Question: Condense the content of this figure into a single sentence.
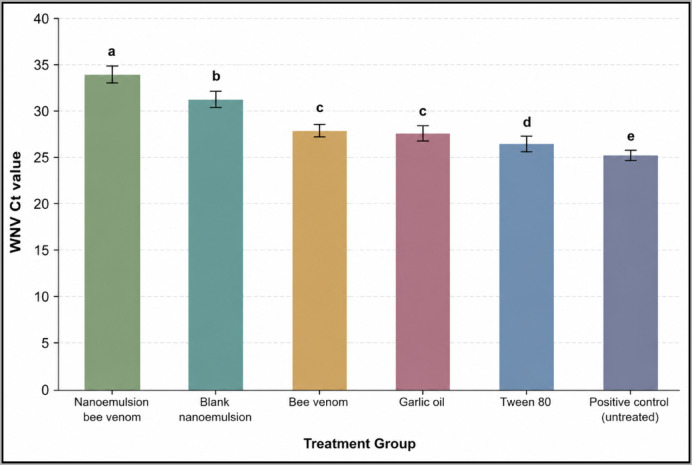
Answer: Effect of Tween 80, garlic oil, blank nanoemulsion, crude bee venom (BV), and bee venom nanoemulsion (BV-NE) on West Nile virus (WNV) Ct values determined by RT-qPCR in infected Vero cells. Higher Ct values indicate lower detectable viral RNA levels. Data are presented as mean ± SEM ( n = 3). Different lowercase letters ( a – e ) indicate statistically significant differences among groups ( p < 0.05; one-way ANOVA followed by Tukey’s HSD multiple comparison test).